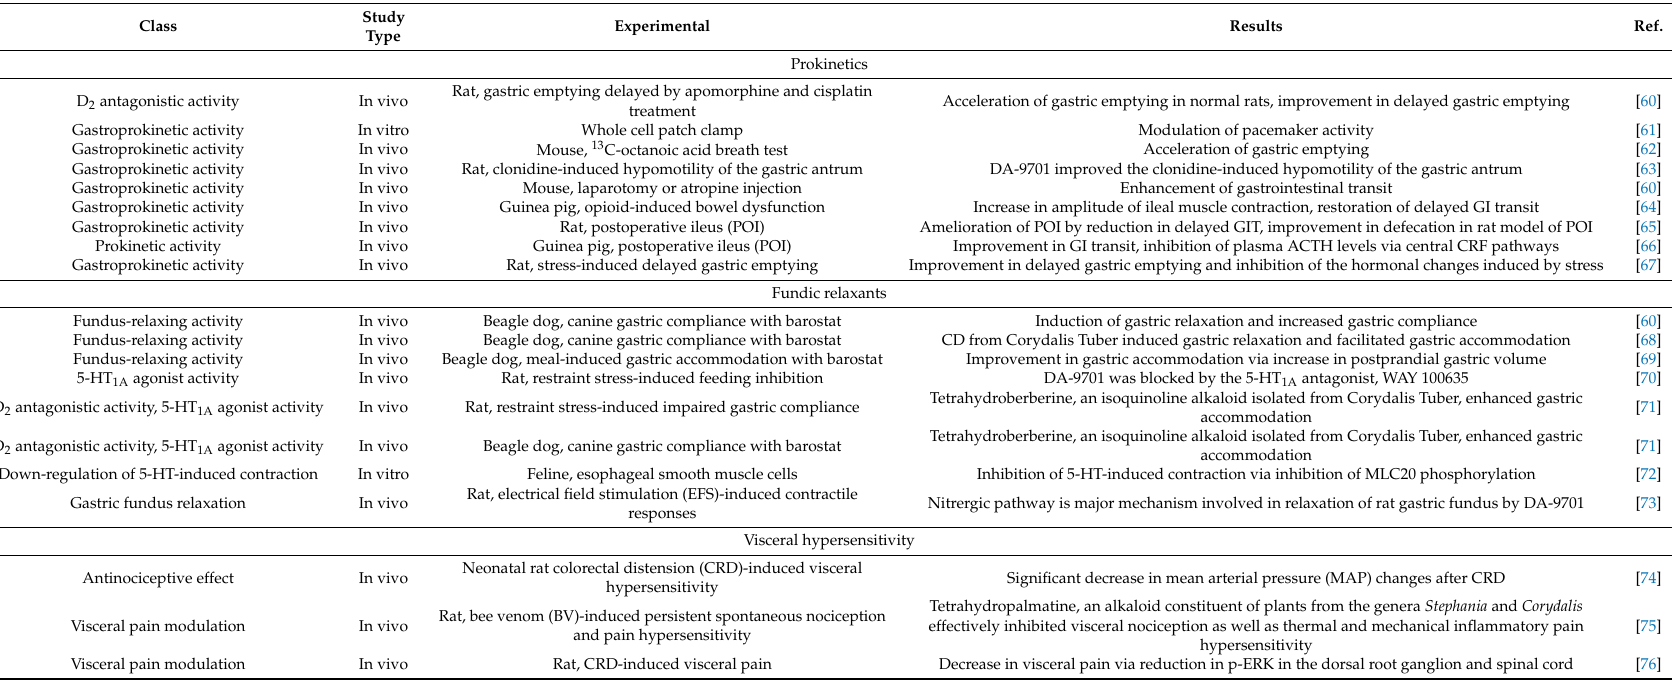
Table 1. Pharmacological profile summary of DA